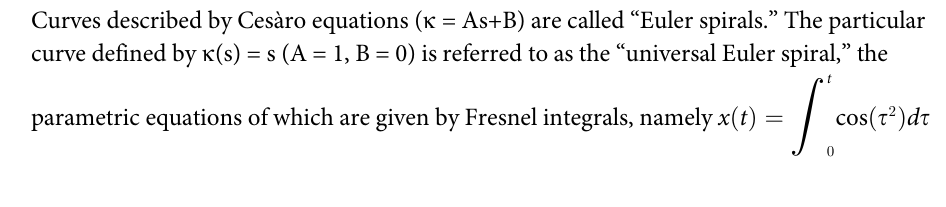
Curves described by Ces à ro equations ( κ = As+B) are called “Euler spirals.” The particular curve defined by κ (s) = s (A = 1, B = 0) is referred to as the “universal Euler spiral,” the parametric equations of which are given by Fresnel integrals, namely x t ð Þ ¼